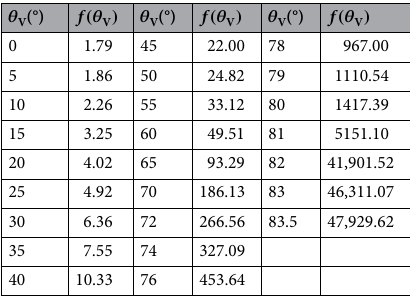
Table 2. the local fluid resistance coefficient at different valve core angle 𝜃 V .